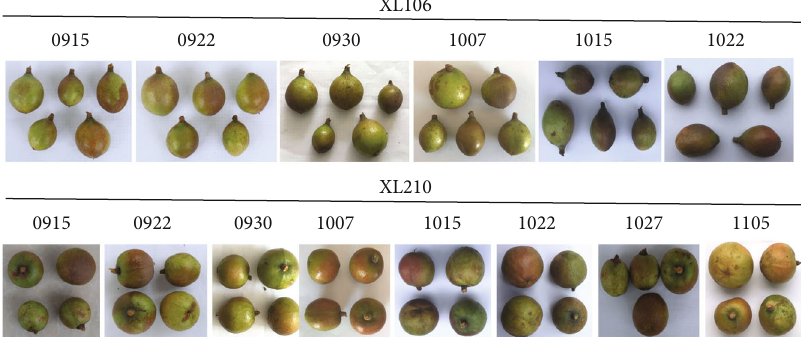
Figure 1: Fruit morphology of the XL106 and XL210 in di ff erent developmental stages. Table 1: Indicator value of characters in di ff erent periods of